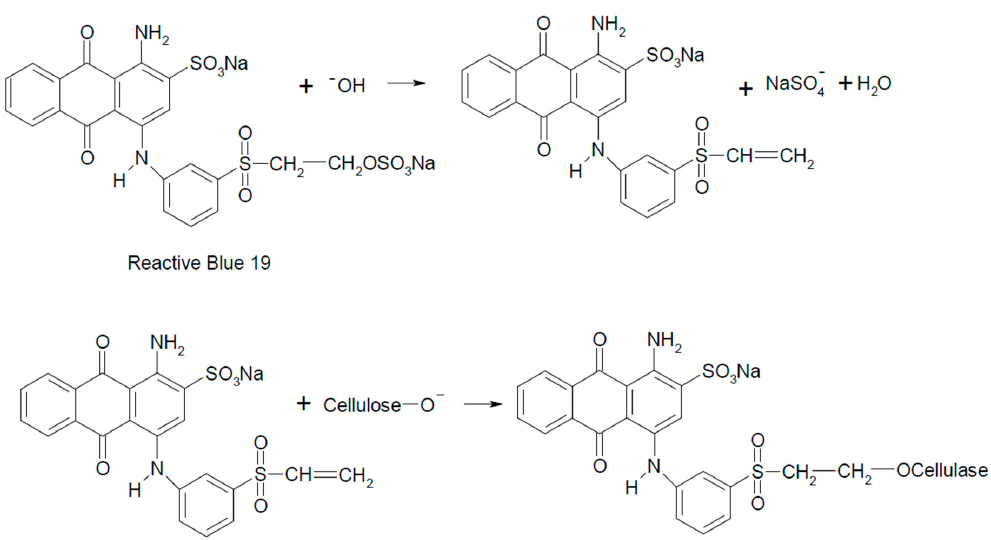
Figure 5. Reaction of Reactive Blue 19 with